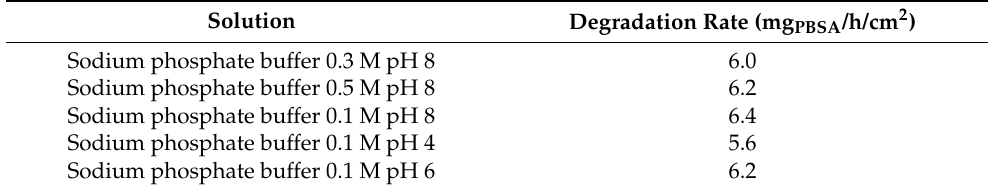
Figure 6. Weight loss (%) of PBSA by cutinase in phosphate buffer at different pH and concentrations as a function of the incubation time (hours). Table 8. Degradation rates (mg/h/cm 2 ) of cutinase on PBSA in phosphate buffer at different pH and concentrations (T = 40 ◦